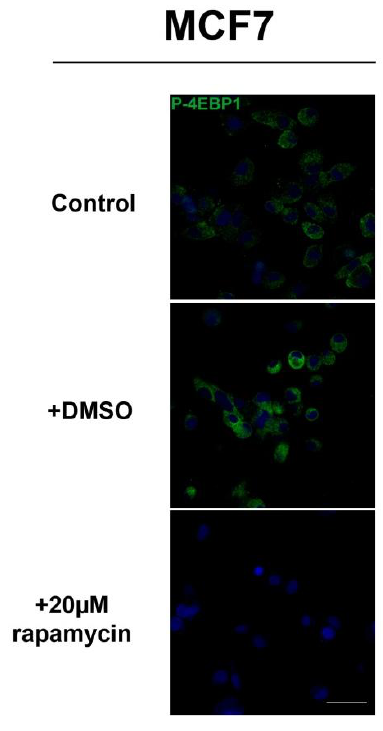
Figure S5. Rapamycin treatment decreases P-4EBP1 levels. Immunocytochemistry for the mTORC1 target P-4EBP1 (green) demonstrates a decrease in levels upon treatment with rapamycin. TOPRO3 (blue) labels nuclei. Scale bars, 20